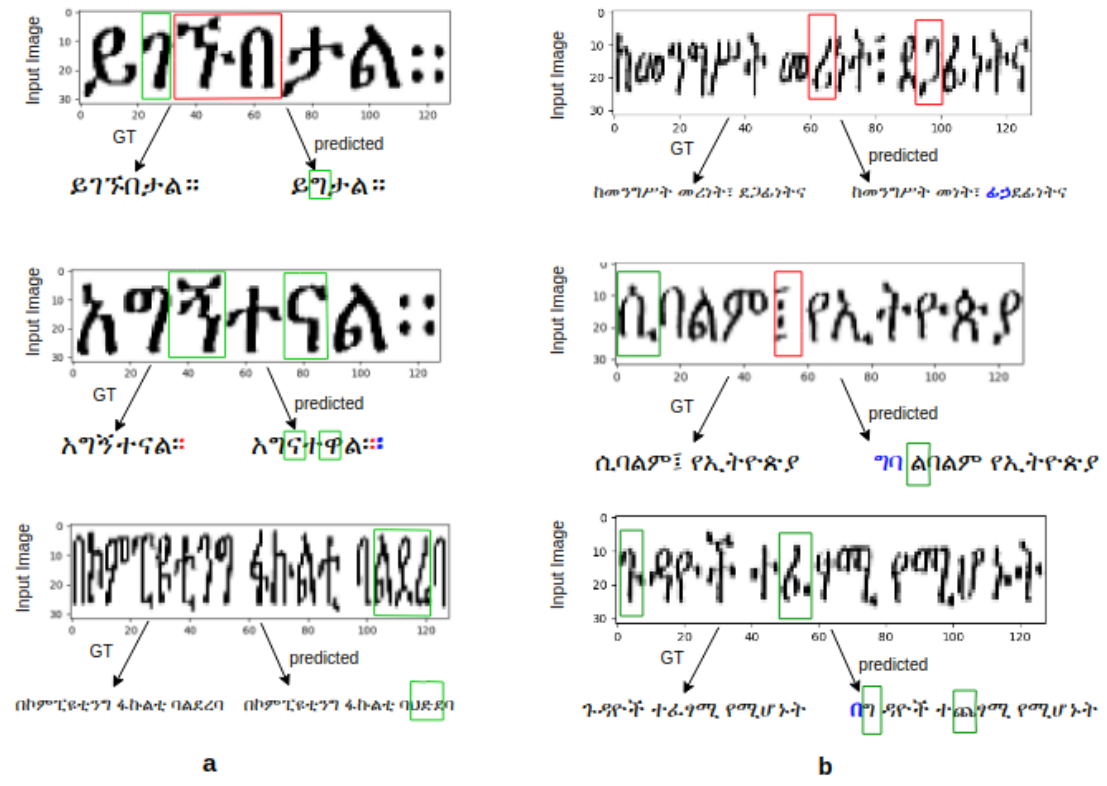
Figure 6. Sample mis-recognized text-line images. ( a ) Printed text-line images. ( b ) Synthetically generated text-line images. The small green and red rectangles are used to mark the substituted and deleted characters, respectively, while the blue color represents inserted